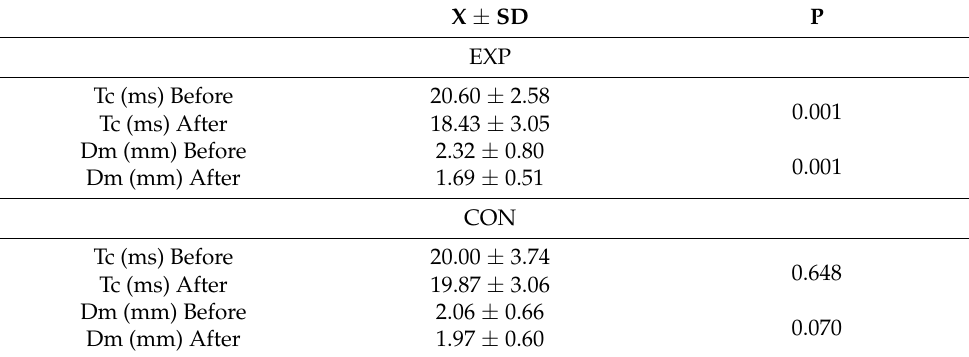
Table 2. Descriptive statistics of the parameters Tc—Contraction Time (ms), and Dm—Maximal Displacement in both groups.